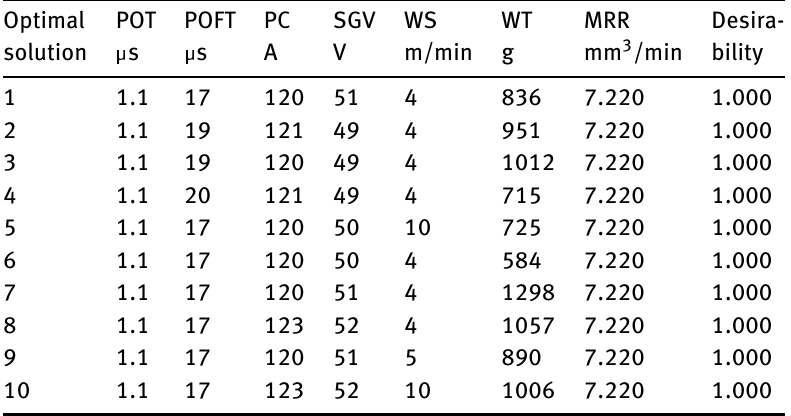
Table 4: Optimal solution after desirability function. Optimal